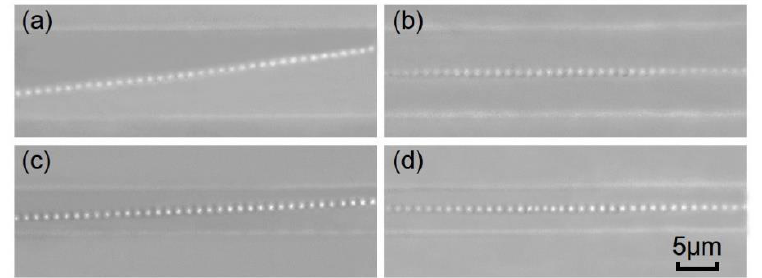
Figure 2. ( a , b ) shows micrographs of apodized fiber gratings fabricated by different methods in a fiber with a core diameter of 9 μm. ( c , d ) shows micrographs of apodized fiber gratings fabricated by different methods in a fiber with a core diameter of 4.4 μm.